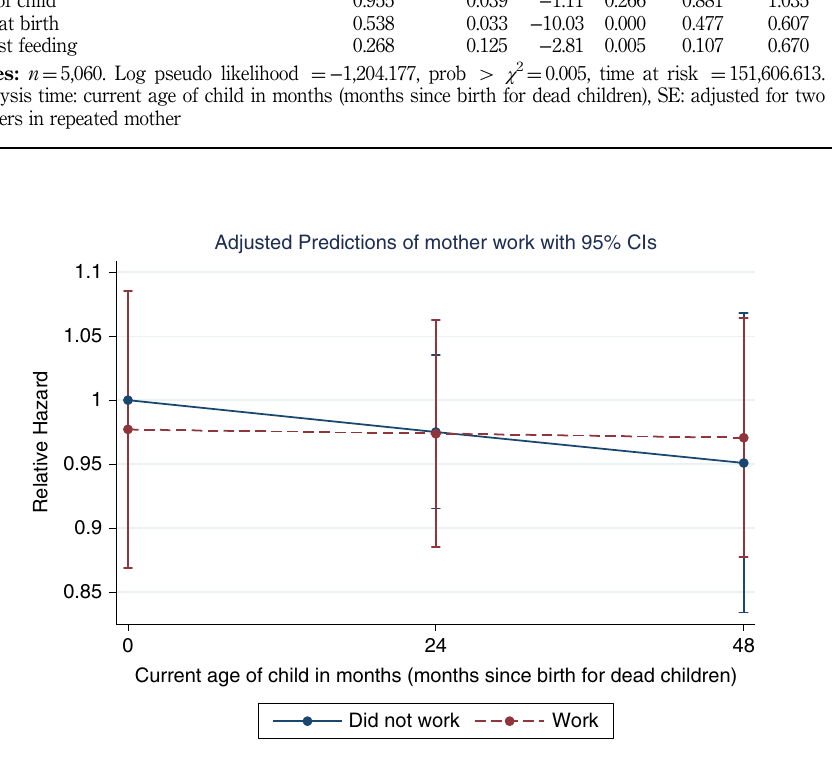
Table II. Results of the cox